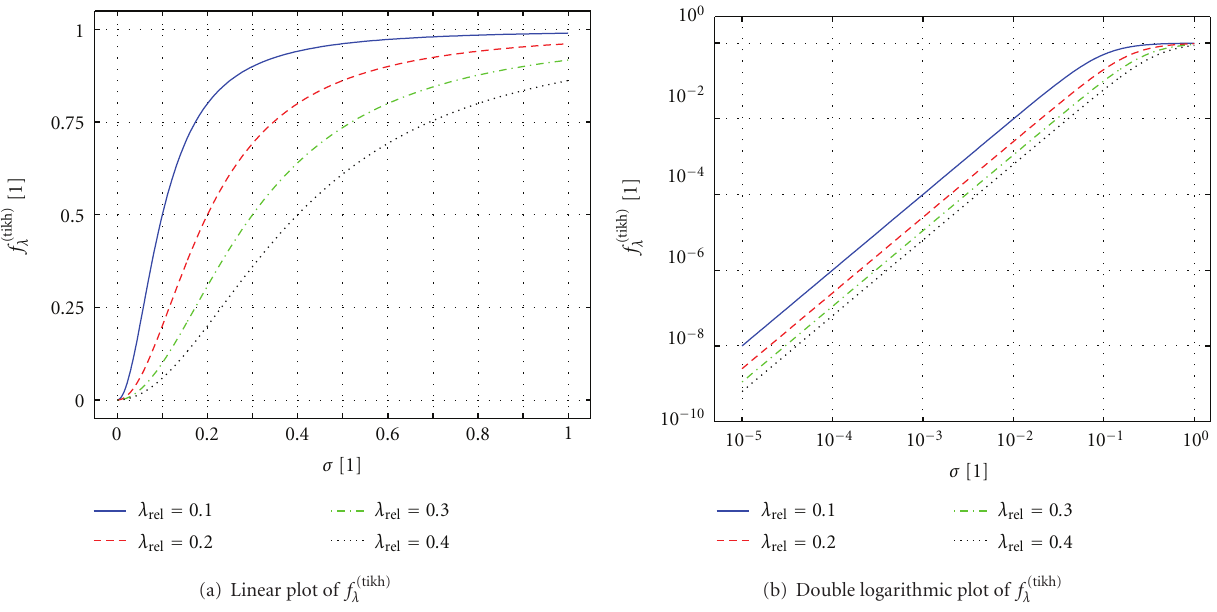
Figure 9: (a) Linear and (b) double logarithmic plot of the Tikhonov filter factor f (tikh) λ as a function of the singular value σ ∈ [10 − 5 ,1].